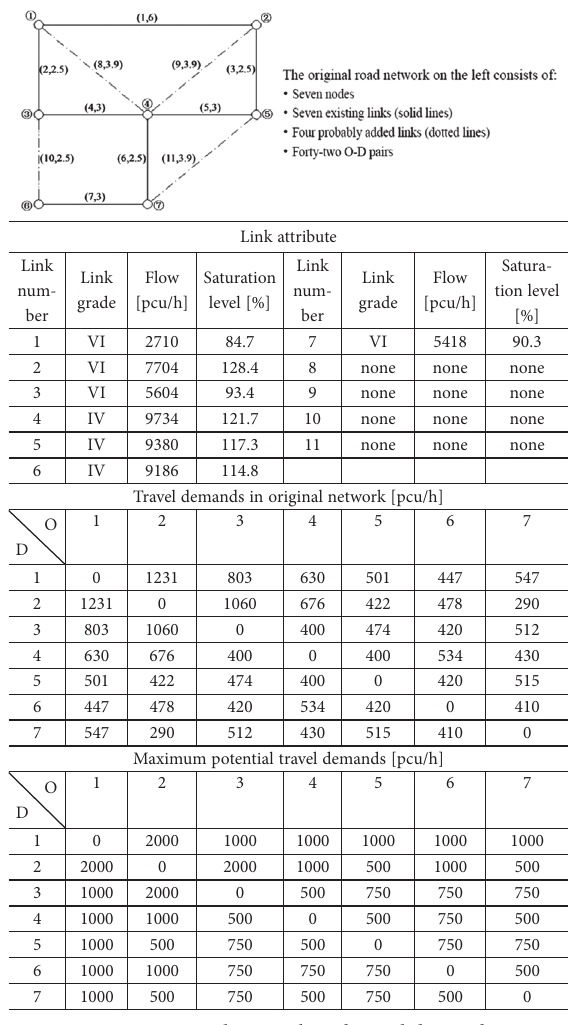
Fig. 4. Original network and travel